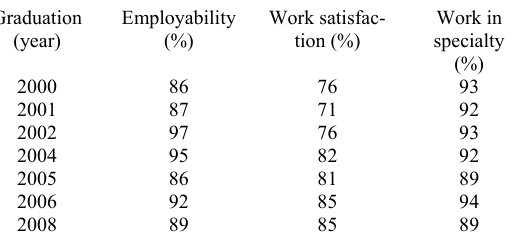
TABLE I. D YNAMICS OF E MPLOYABILITY AND W ORK S ATISFACTION